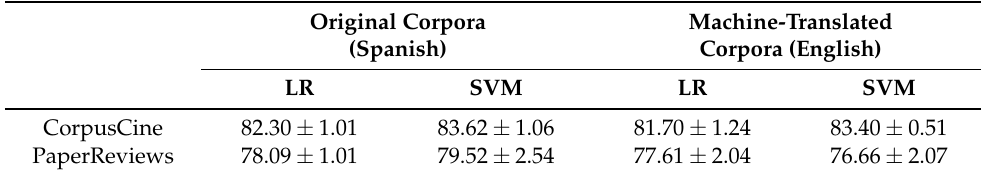
Table 3. Comparison of sentiment analysis performance (in terms of overall accuracy) between Span- ish corpora and English-translated corpora. LR: logistic regression, SVM: support vector machines. Original Corpora